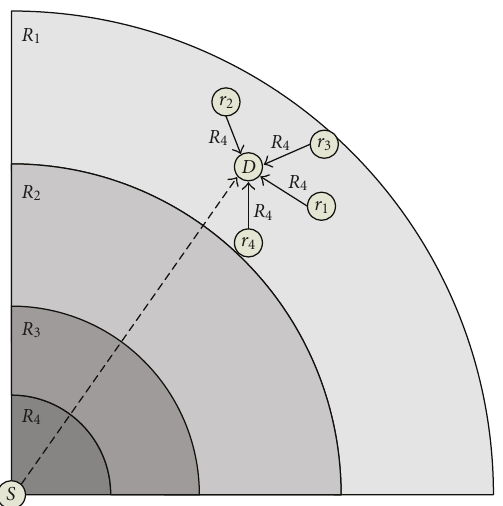
Figure 2: Example of cooperative